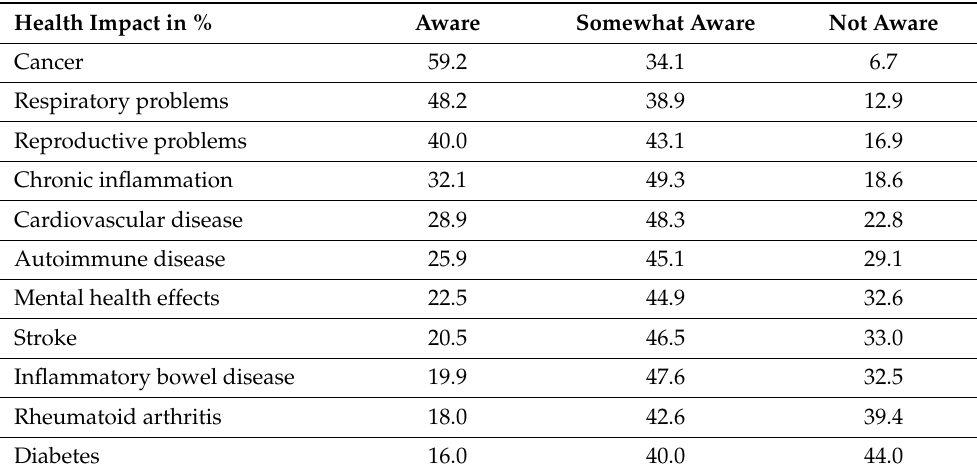
Table 4. Awareness about the impact of the plastic lifecycle on the development of specific dis- eases/health